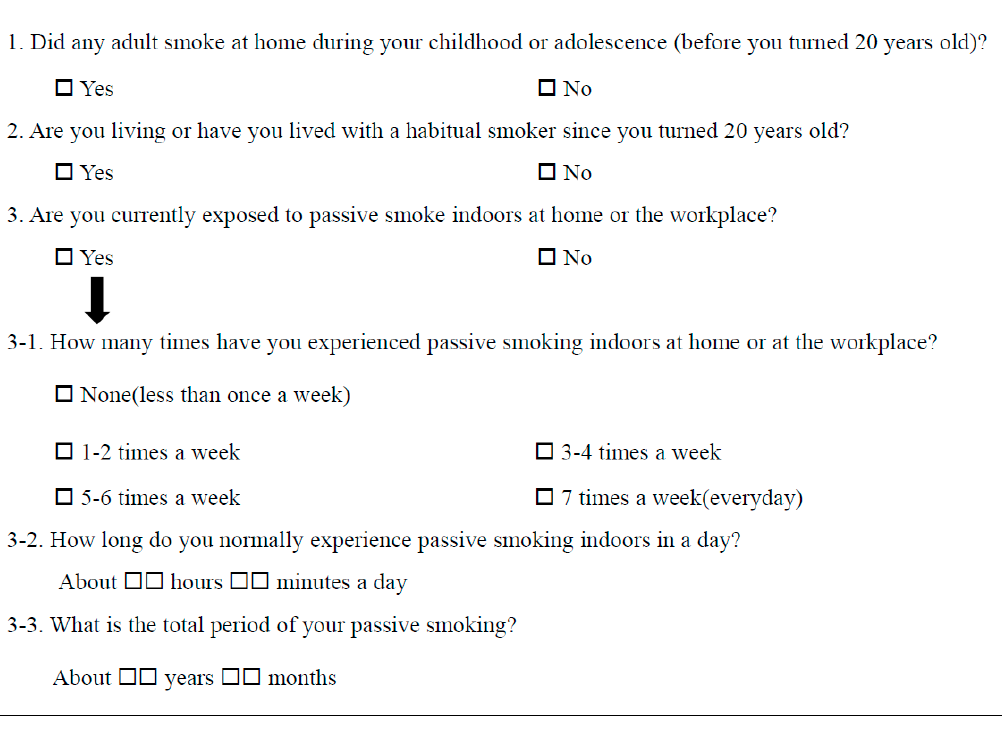
Figure 1. Questionnaire of secondhand smoke exposure.